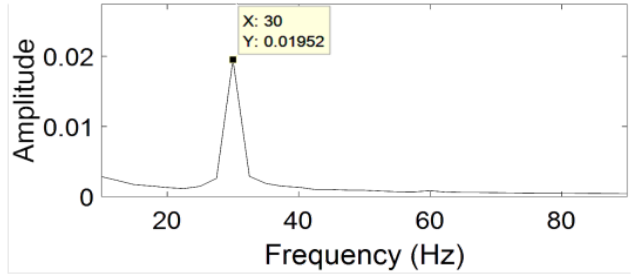
Figure 38. The influence of k ppll on i gd.